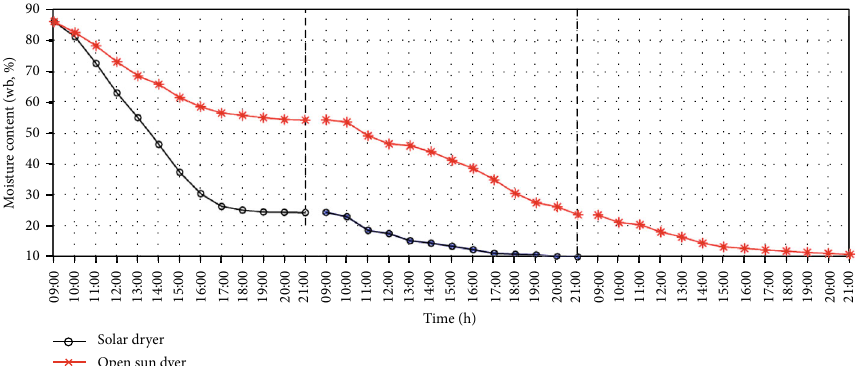
Figure 12: Variation of moisture content (w.b) of the solar dryer and open sun drying with drying time for red pepper samples.